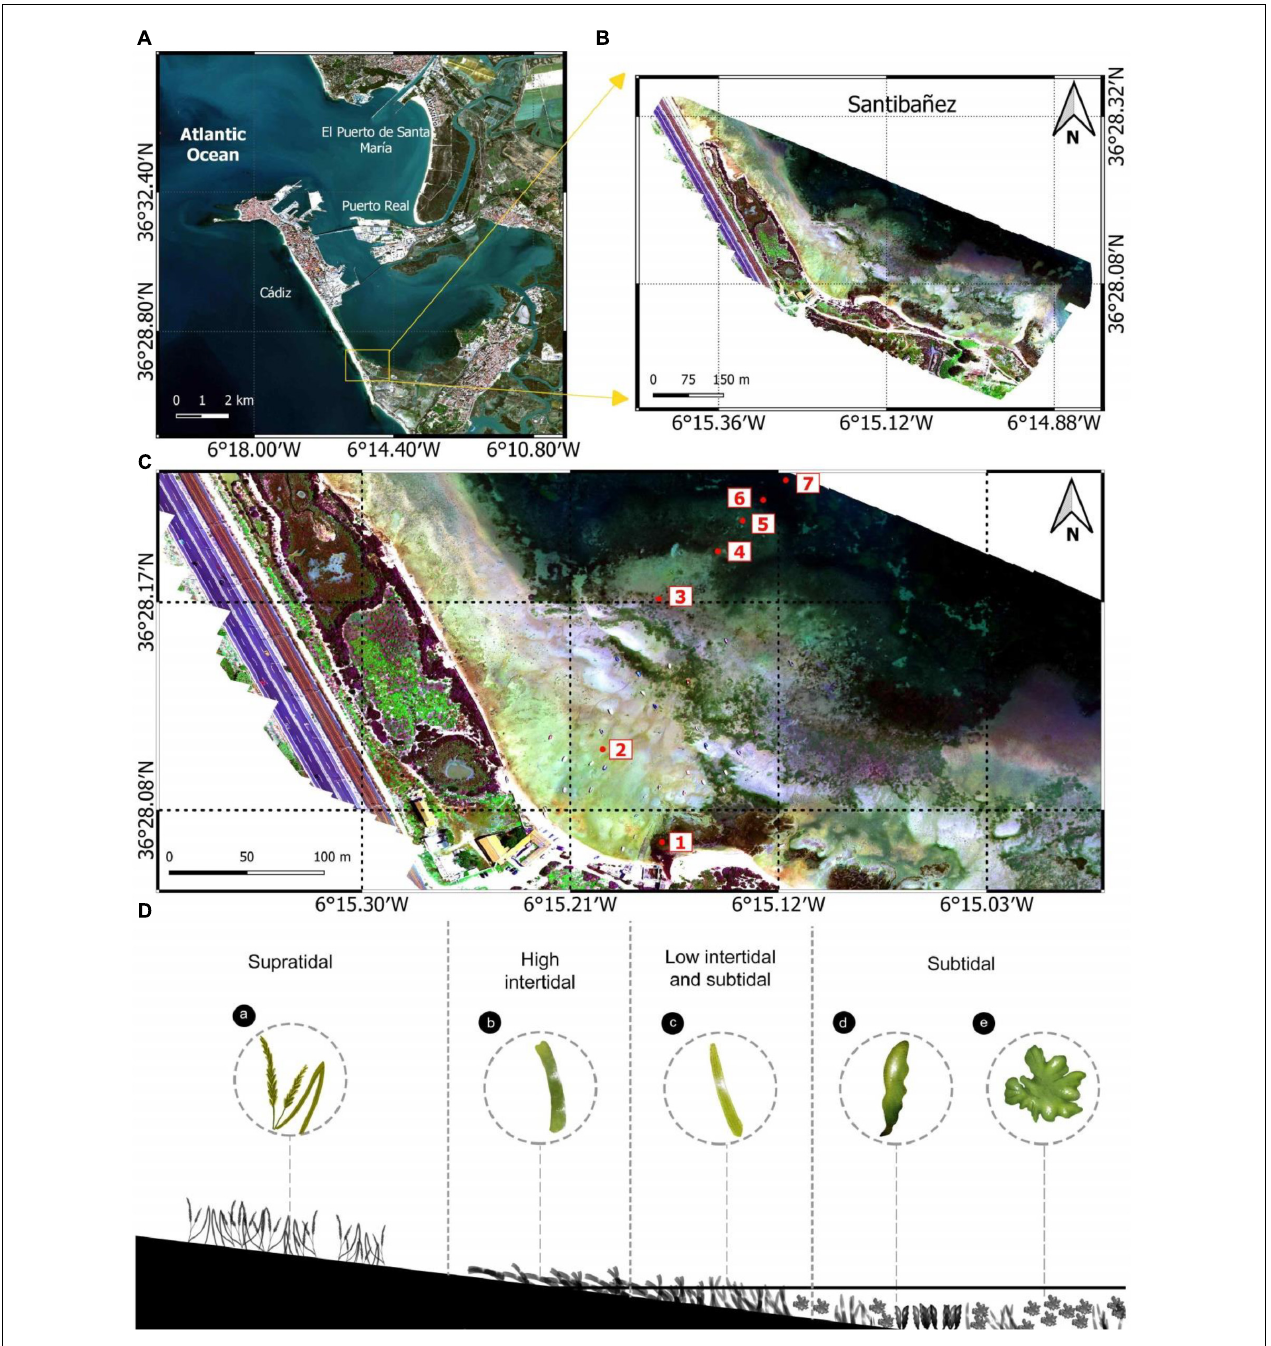
FIGURE 1 | (A) Sentinel-2 image of Cádiz Bay (Spain). Framed in yellow, the study area of Santibañez. (B) RGB orthomosaic generated from images taken with the MicaSense RedEdge-MX dual multispectral camera. (C) Zoom of the study area in which the seven sampling points are represented, whose coordinates and taxonomic information are detailed in Table 1 . (D) Diagram of the distribution of the different species monitored in Santibañez. From left to right: supratidal ( a: Spartina maritima ), high intertidal ( b: Zostera noltei ); Low intertidal and subtidal ( c: Cymodocea nodosa , d: Caulerpa prolifera , and e: Ulva